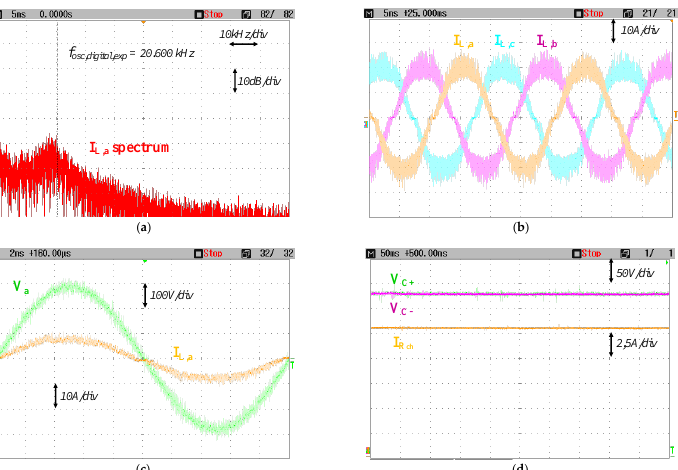
Figure 19. Experimental waveforms of the Three-Phase Vienna converter with PFC regulation including DPSSOCC control: ( a ) current spectrum, ( b ) input current, ( c ) grid voltage and current for one phase and ( d ) output current and regulated DC voltage bus.